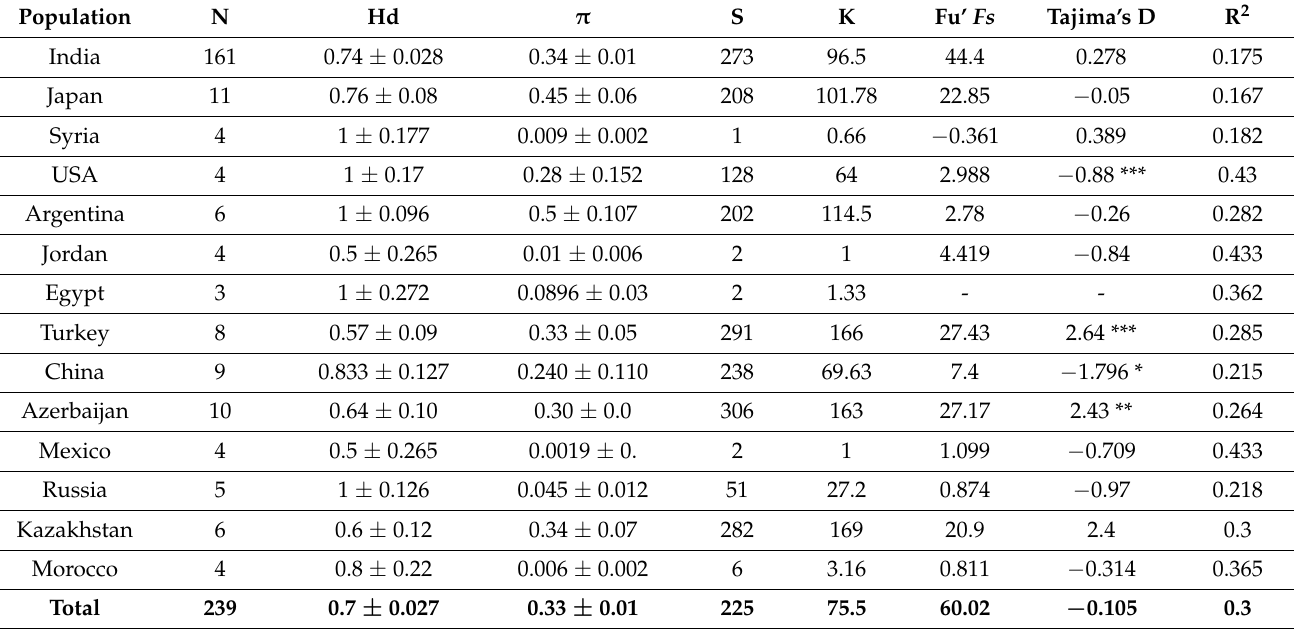
Table 1. Analysis of genetic diversity and neutrality test of B. sorokiniana representing different